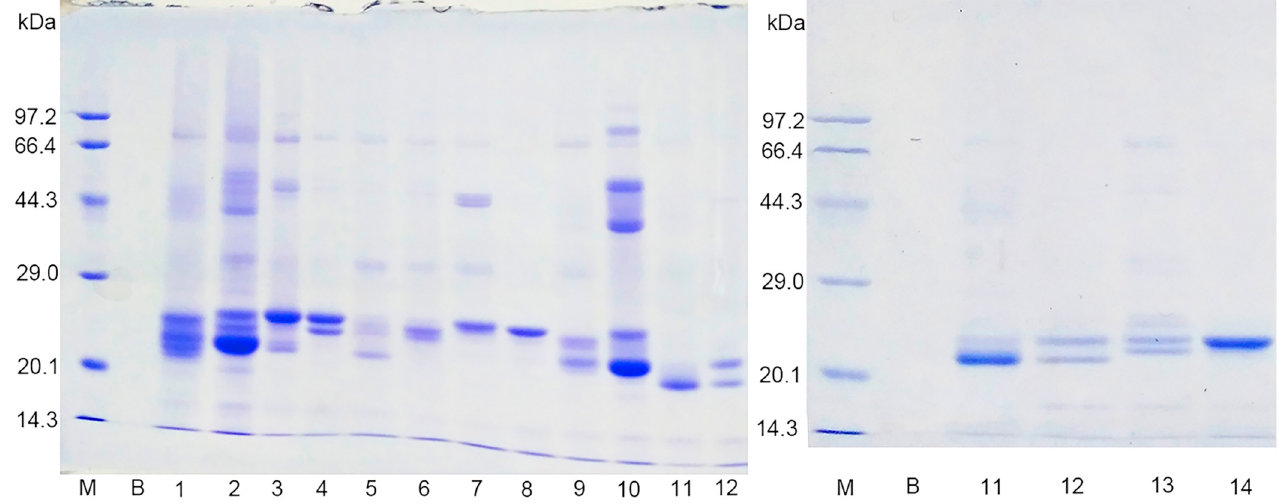
Figure 2. SDS − PAGE analysis of hGPx3 and hGPx3 mutants under non − reducing conditions with- out boiling treatment. Lanes are as follows: M: marker; B: blank; 1: Sec − hGPx3; 2: Sec − hGPx3 − C8S; 3: Sec − hGPx3 − C8/77S; 4: Sec − hGPx3 − C8/132S; 5: Sec − hGPx3 − C77S; 6: Sec − hGPx3 − C132S; 7: Sec − hGPx3 − C77/132S; 8: Sec − hGPx3C8/77/132S; 9: Ser − hGPx3; 10: Ser − hGPx3 − C8S; 11: Sec − shGPx3; 12: Sec − shGPx3 − C77S; 13: Sec − shGPx3 − C132S; 14: Sec − shGPx3 − C77/132S.